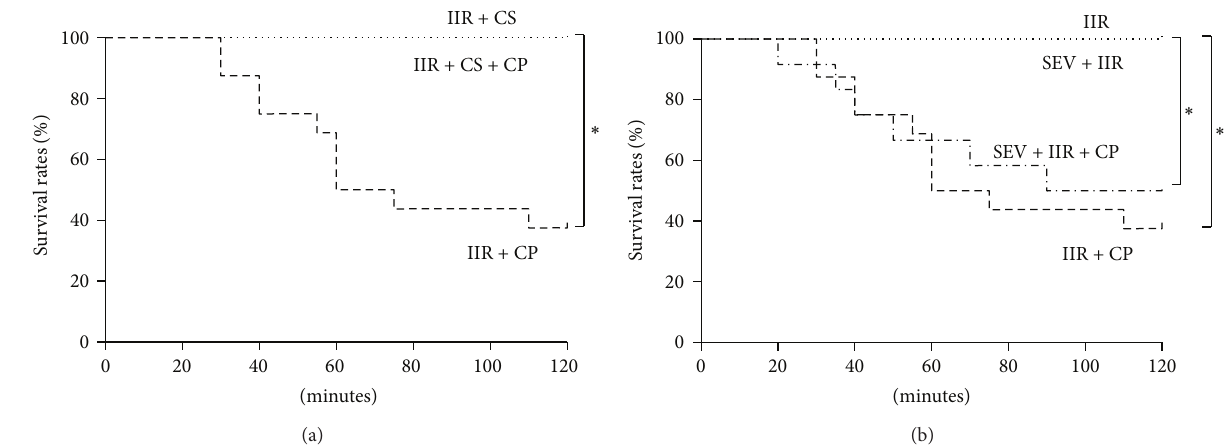
Figure 1: Survival rates after IIR injury. SH group (Sham-operated group), IIR group (75 min intestinal ischemia and 2 h reperfusion), IIR + CP group (IIR group + Compound 48/80 1mg/kg), IIR + CS group (50 mg/kg cromolyn sodium treated IIR group), IIR + CS + CP group (50 mg/kg cromolyn sodium treated IIR group + Compound 48/80 1mg/kg), SEV + IIR group (2.3% sevoflurane pretreated IIR group), SEV + IIR + CP group (2.3% sevoflurane pretreated IIR group + Compound 48/80 1mg/kg). The survival rates in 2 h after reperfusion were 100% in all groups except IIR + CP and SEV + IIR + CP groups. Results are expressed as percentage of live animals, 𝑛 = 6 per group, whereas 𝑛 = 16 in IIR + CP group and 𝑛 = 12 in SEV + IIR + CP group. ∗ indicated that 𝑃 value was less than